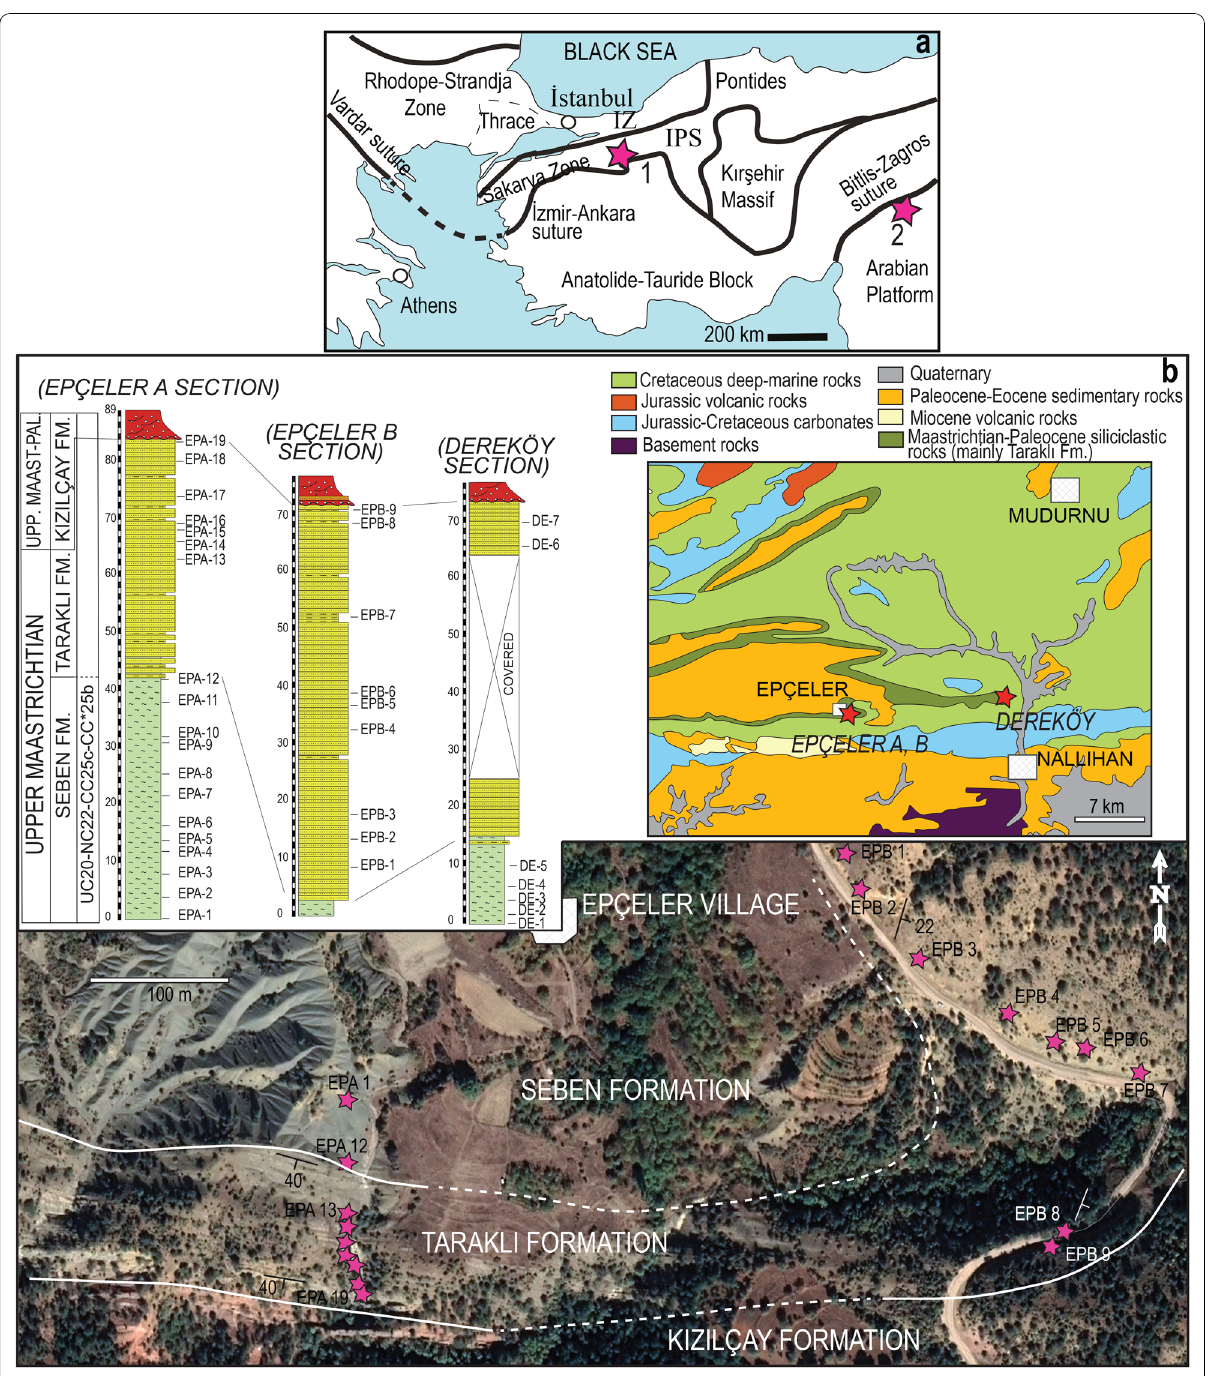
Fig. 1 a Tectonic map of the northeastern Mediterranean region showing the major sutures and continental blocks and the location of the study areas in the Central Sakarya Basin (1) and Arabian Platform margin (2) (map simplified from Okay & Tüysüz, 1999). b Geological map of the Epçeler, Nallıhan region and lithostratigraphic log of the upper part of the Seben Formation and the Taraklı Formation (map simplified from MTA 2011). Sampling points in Epçeler A and B sections are